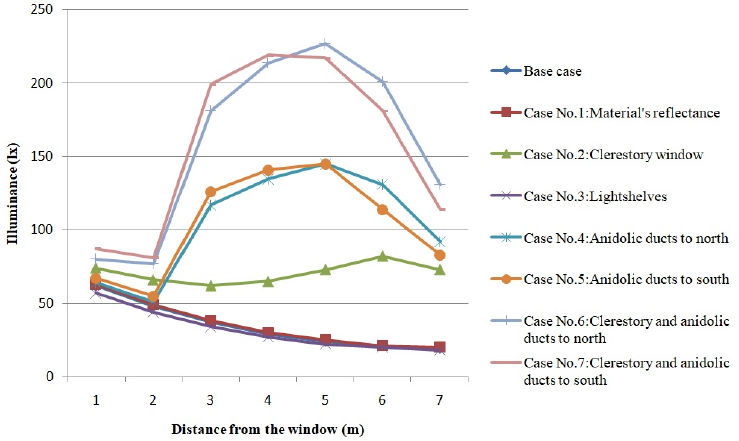
Figure 23. Comparison of average illuminance levels on the desks plane on 21 st of December at 3:00 pm.